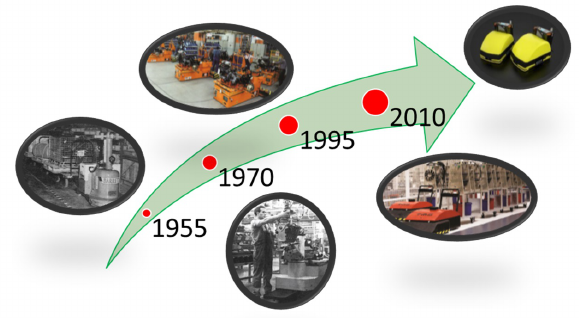
Figure 2: The history of automated logistics